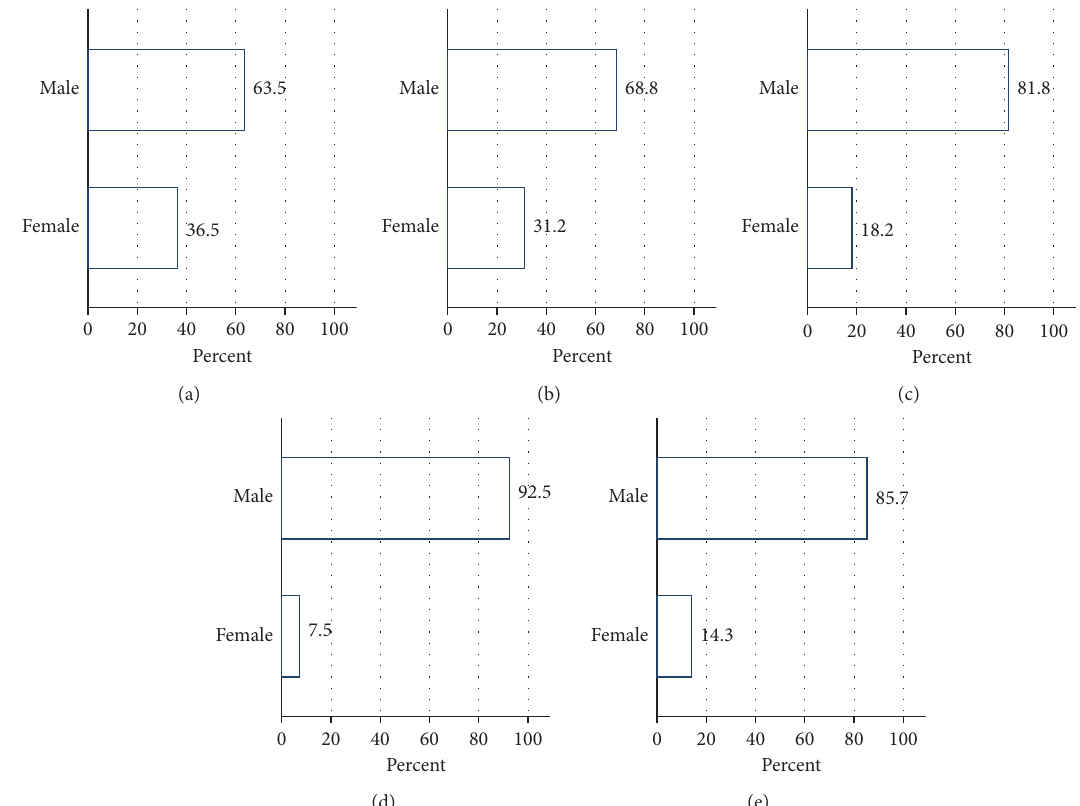
Figure 3: Percentage of male and female respondents in the five subcounties. There was male domination of fish farming in all the subcounties, with high disparity observed in Othaya subcounty. High female participation was observed in Kieni East subcounty. (a) Kieni East. (b) Kieni West. (c) Nyeri central. (d) Othaya. (e)